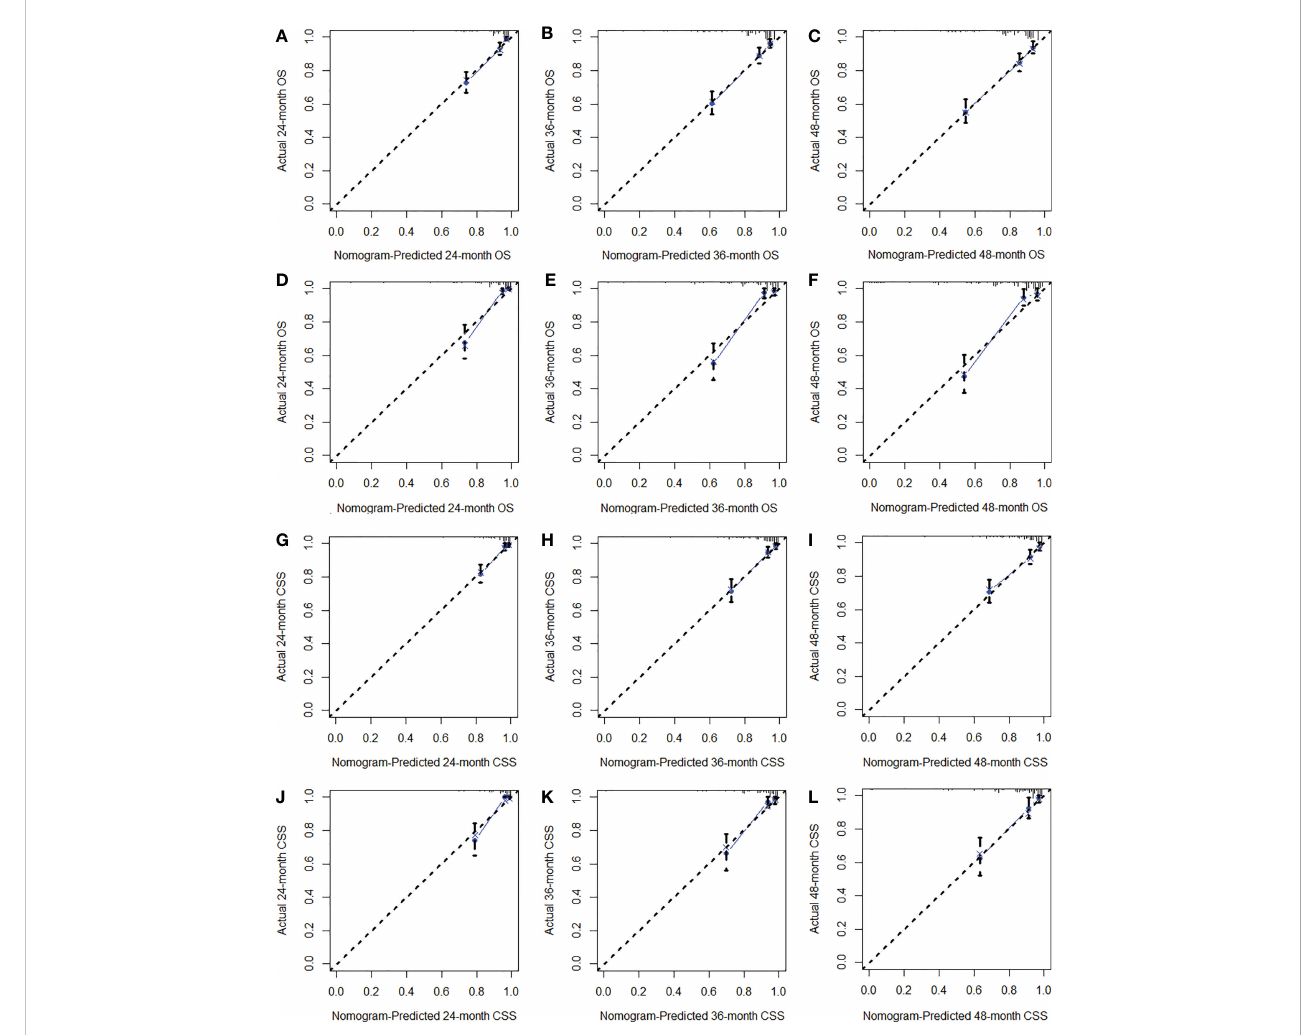
FIGURE 6 The calibration curves of the training cohort (A – C) and veri fi cation cohort (D – F) for OS analysis and of the training cohort (G – I) and veri fi cation cohort (J – L) for CSS